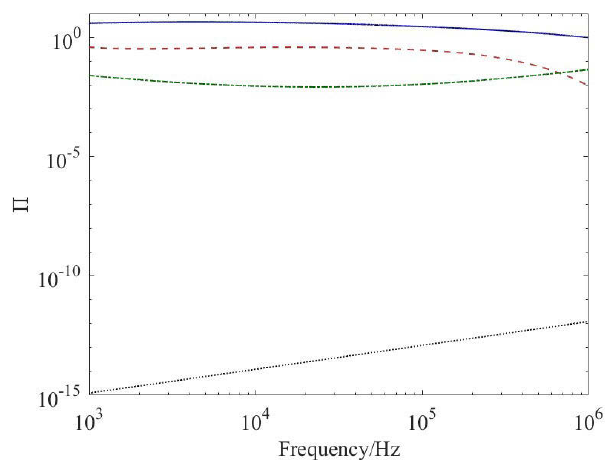
Fig.2: Dimensionless number, Π , for SC ( – ), VS ( – – ), AT ( - ⋅- ) and EL ( ⋅⋅⋅ ).